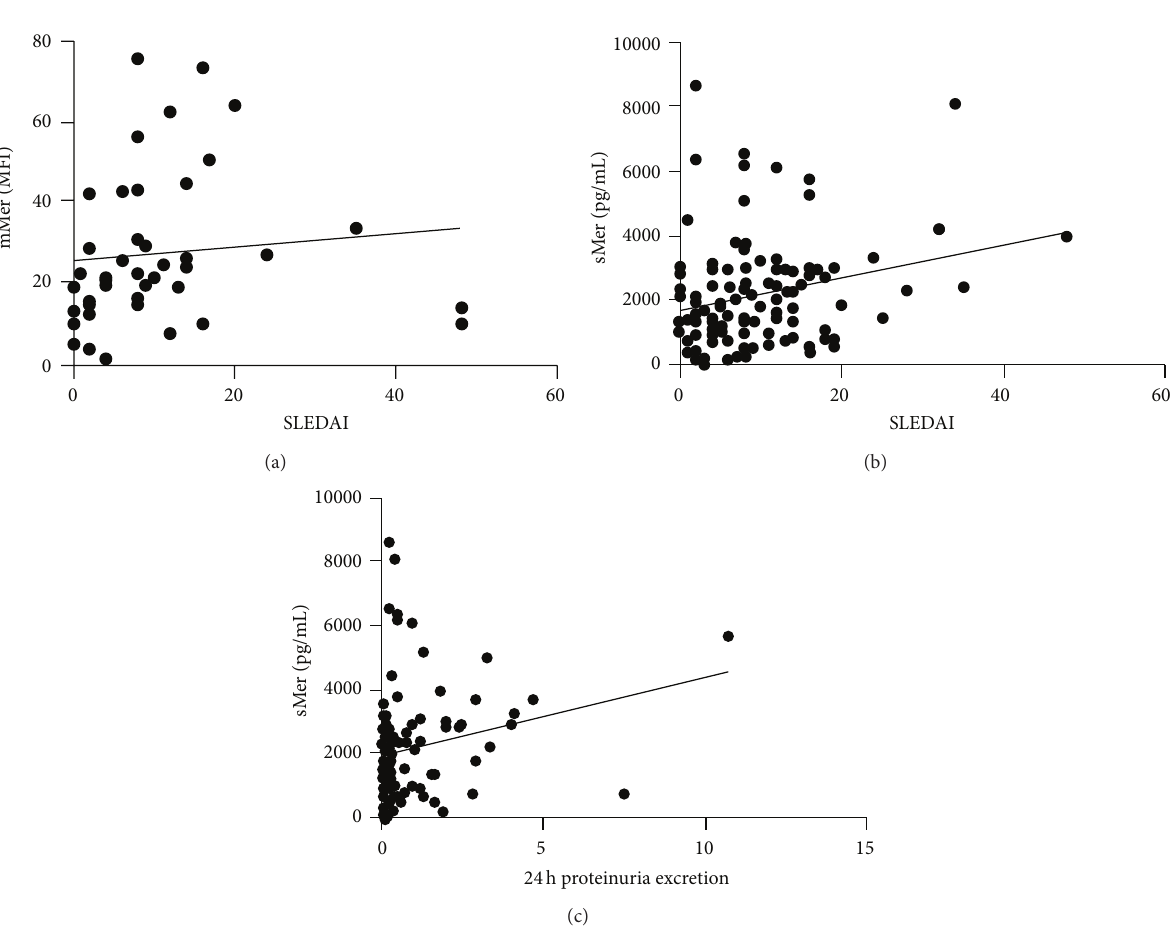
Figure 3: Correlations of mMer and sMer with different clinical parameters such as SLEDAI score and 24 hours proteinuria excretion in patients with SLE. (a) mMer expression on CD14+ monocytes/macrophages was positively correlated to SLEDAI score. (b) sMer in plasma had positive correlation to SLEDAI score, 24 h: 24 hours proteinuria excretion. mMer: membrane Mer tyrosine kinase; sMer: soluble Mer tyrosine kinase; SLEDAI: SLE disease activity index; Spearman’s rank correlation test was used to assess